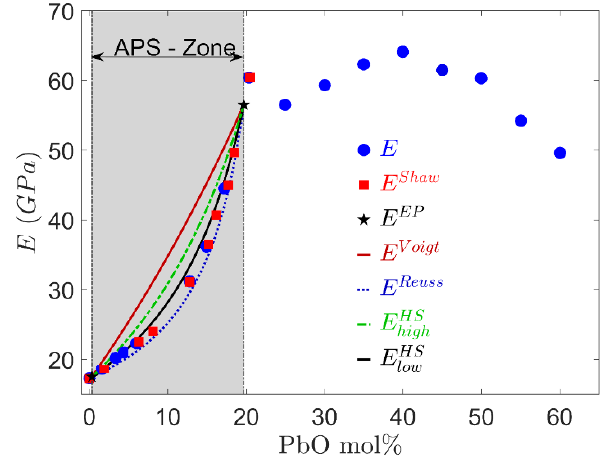
Figure 12. Plot of Young’s Modulus of PbO-B 2 O 3 glasses as a function of the PbO mol%. Experimental data of Young’s modulus of PbO-B 2 O 3 glasses with mole fraction composition are presented in Table A1 blue points from [141,142], red squares from [135], black stars for end points from [141]. Predictive ranges of different models within the APS zone (gray section): solid red line for Voigt upper bound, blue dotted line for Reuss lower bound, green dashed line for HS upper bound and black solid line for HS lower bound